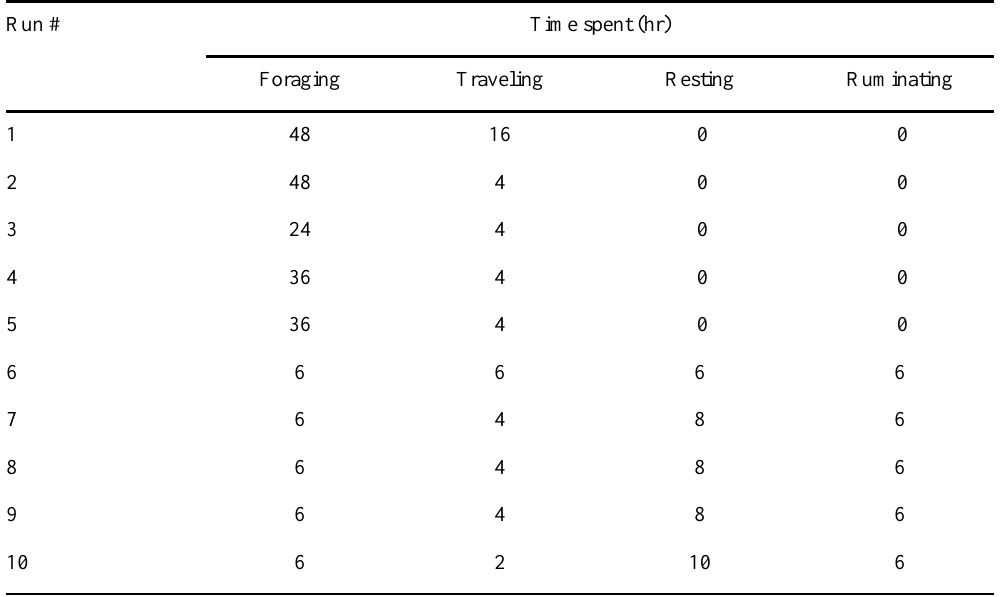
Table 4 . Parameters for the 10 calibration runs. Run #8 was selected as best fitting the mean of the values for habitat use and total distance traveled by the corresponding 12 real moose. Table 4A. Time parameters for the 10 calibration runs.